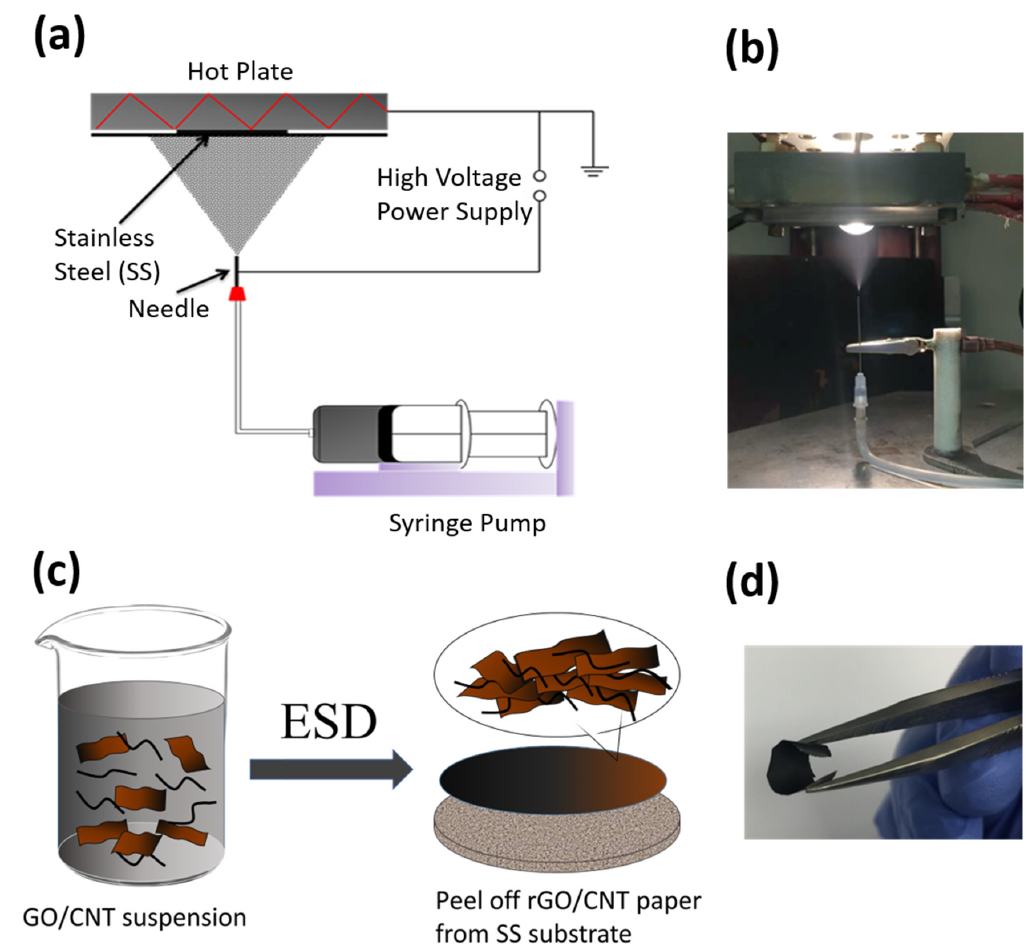
Figure 1. ( a ) Schematic illustration of ESD set-up that was used to fabricate rGO / CNT samples, Digital images of ( b ) shows actual ESD set-up, ( c ) Schematic of rGO / CNT fabrication and ( d ) a digital image of free-standing rGO / CNT paper.